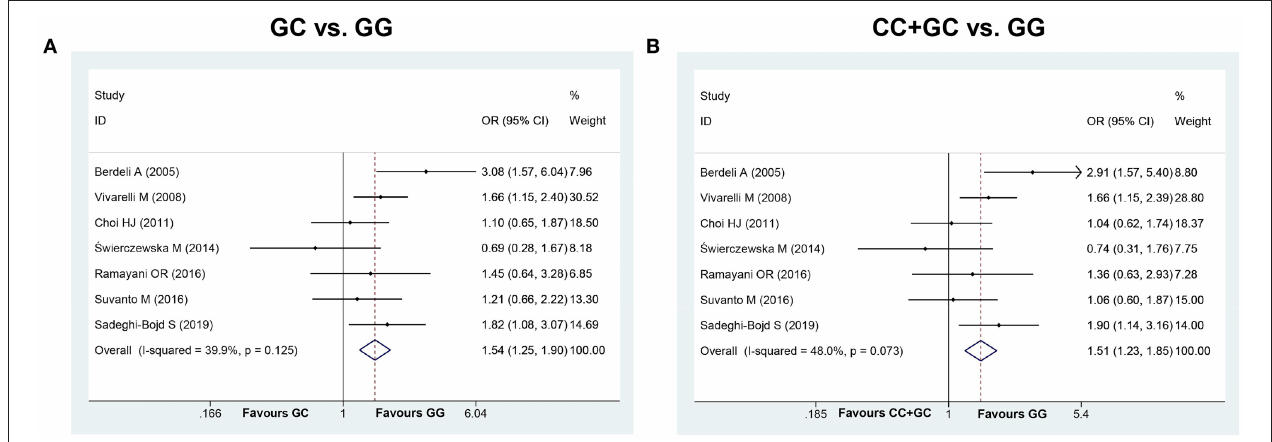
FIGURE 2 | Forest plots ( A : heterozygous model; B : dominant model) for the association between MIF -173G > C polymorphism and INS susceptibility.